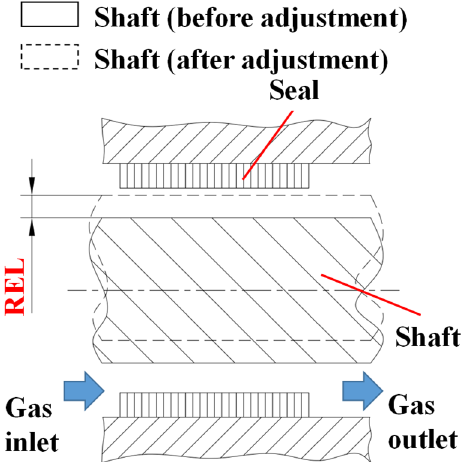
Figure 2. Schematic diagram of radial eccentricity of